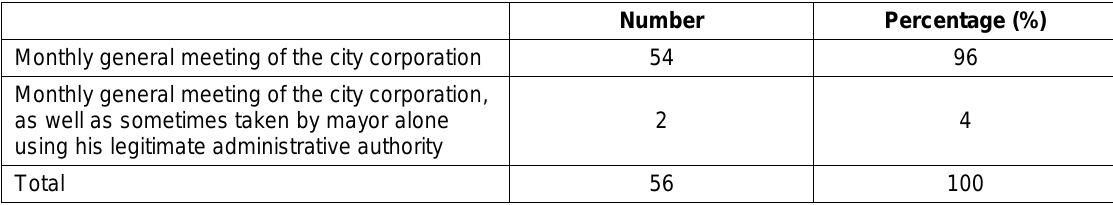
Table 2: Opinions on locus of decision-making (representatives and officials)